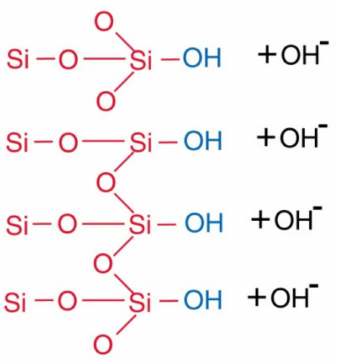
Figure 5. The water content of amorphous silica (shown in red) is predominately in the form of silanol groups shown in blue), where hydroxyl groups are structurally bonded to the silica